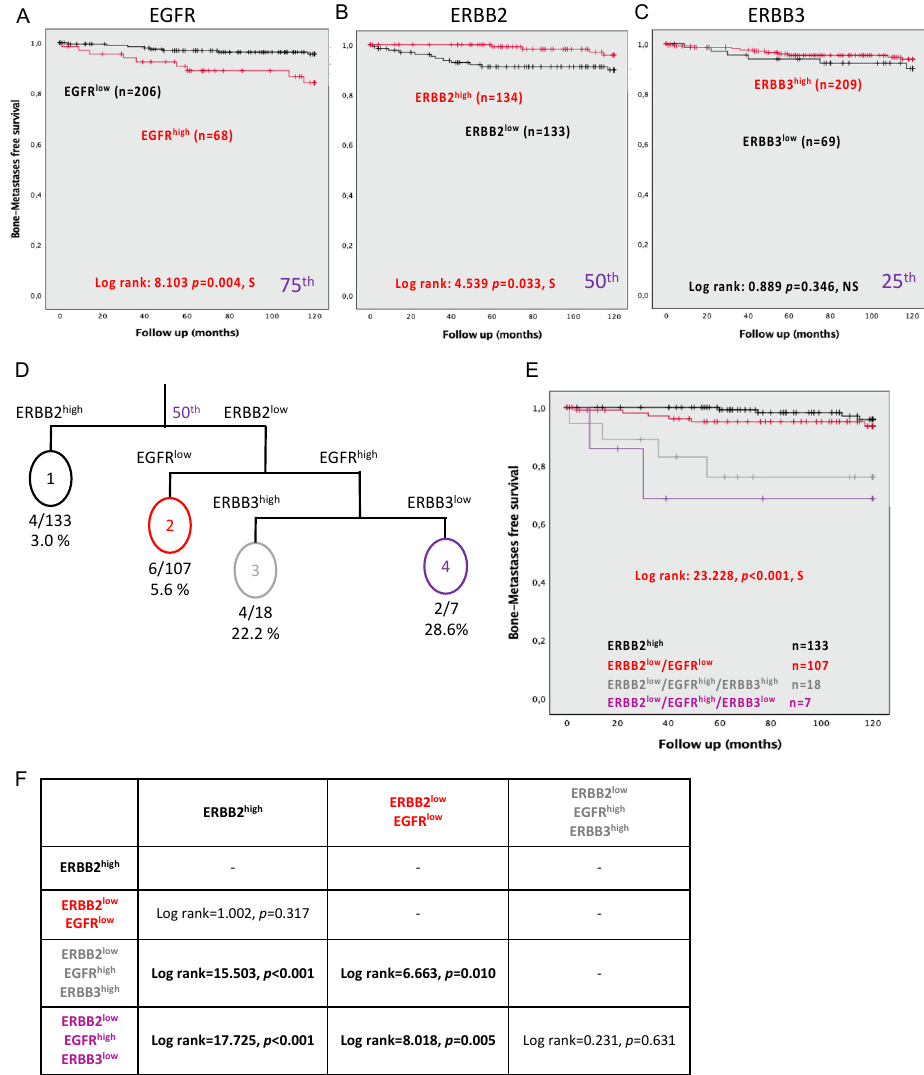
Figure 3. Association of the protein expression in the epithelial cells of tumor cores with the development of bone metastases at 10 years. Kaplan–Meier curves for ( A ) EGFR with a cutoff at the 75th percentile, ( B ) ERBB2 with a cutoff using the median, and ( C ) ERBB3 with a cutoff at the 25th percentile. ( D ) Survival tree, including EGFR, ERBB2, ERBB3, and bone metastases in an RPART model. ( E ) Kaplan–Meier plot combines EGFR, ERBB2, and ERBB3 expression. ( F ) Summary table of log rank between each of the conditions of expression of ERBB members. Significance is indicated by log-rank test. p < 0.05 was considered significant; NS, not significant; S,